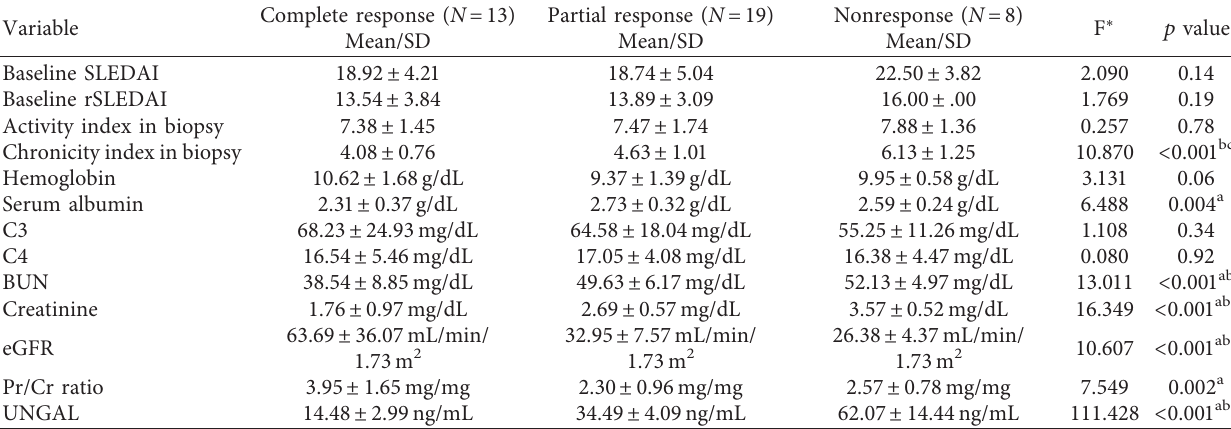
Table 3: Baseline characteristics and laboratory data of different groups (classified according to renal response to induction).